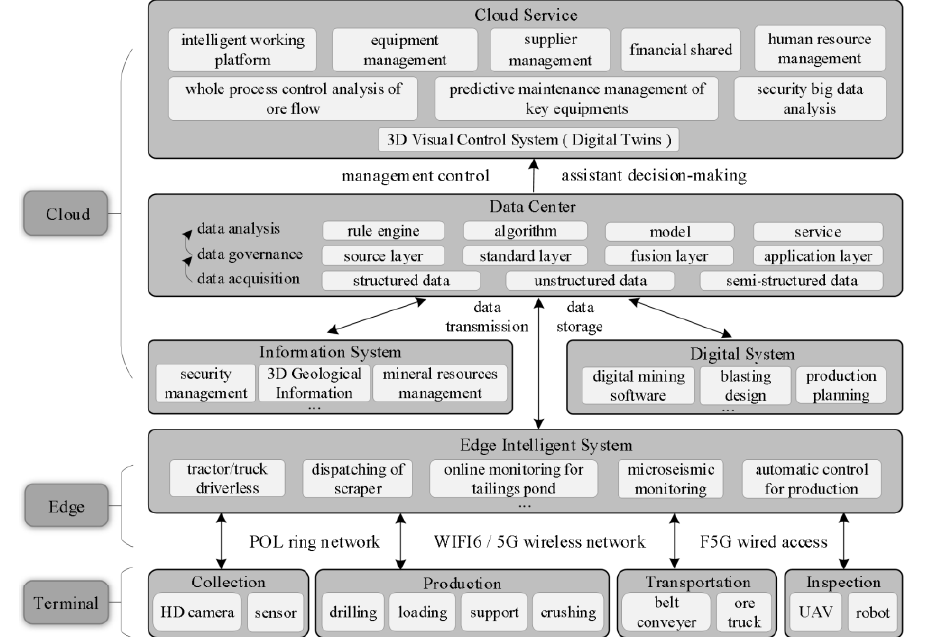
Figure 2. The technical architecture of the CM mode.